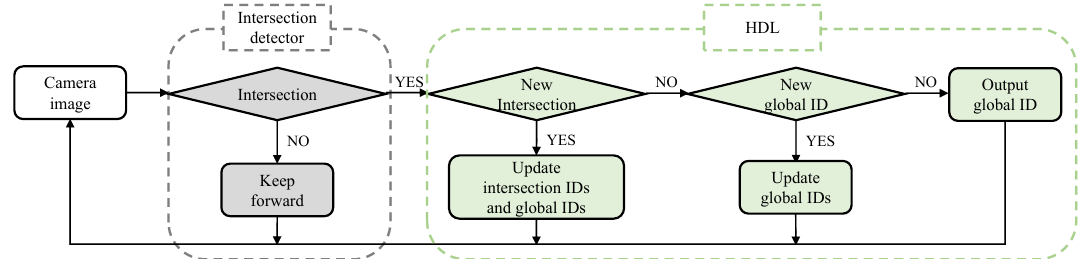
Figure 4. Updating strategy of intersection topological map. The system first perceives if the vehicle encounters an intersection. For a positive detection, the system checks if the image represents a new intersection or not. For a new intersection, the image will be assigned with new intersection and global ID. Both the image and its ID labels will be added into the